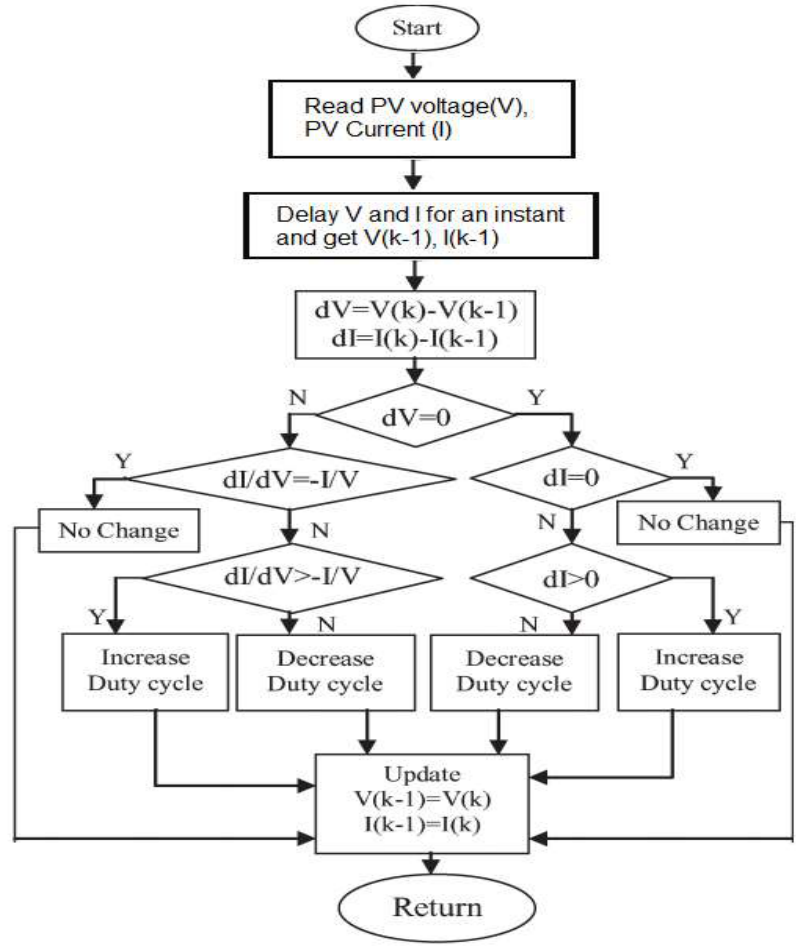
Figure 8. Incremental conductance algorithm flowchart.